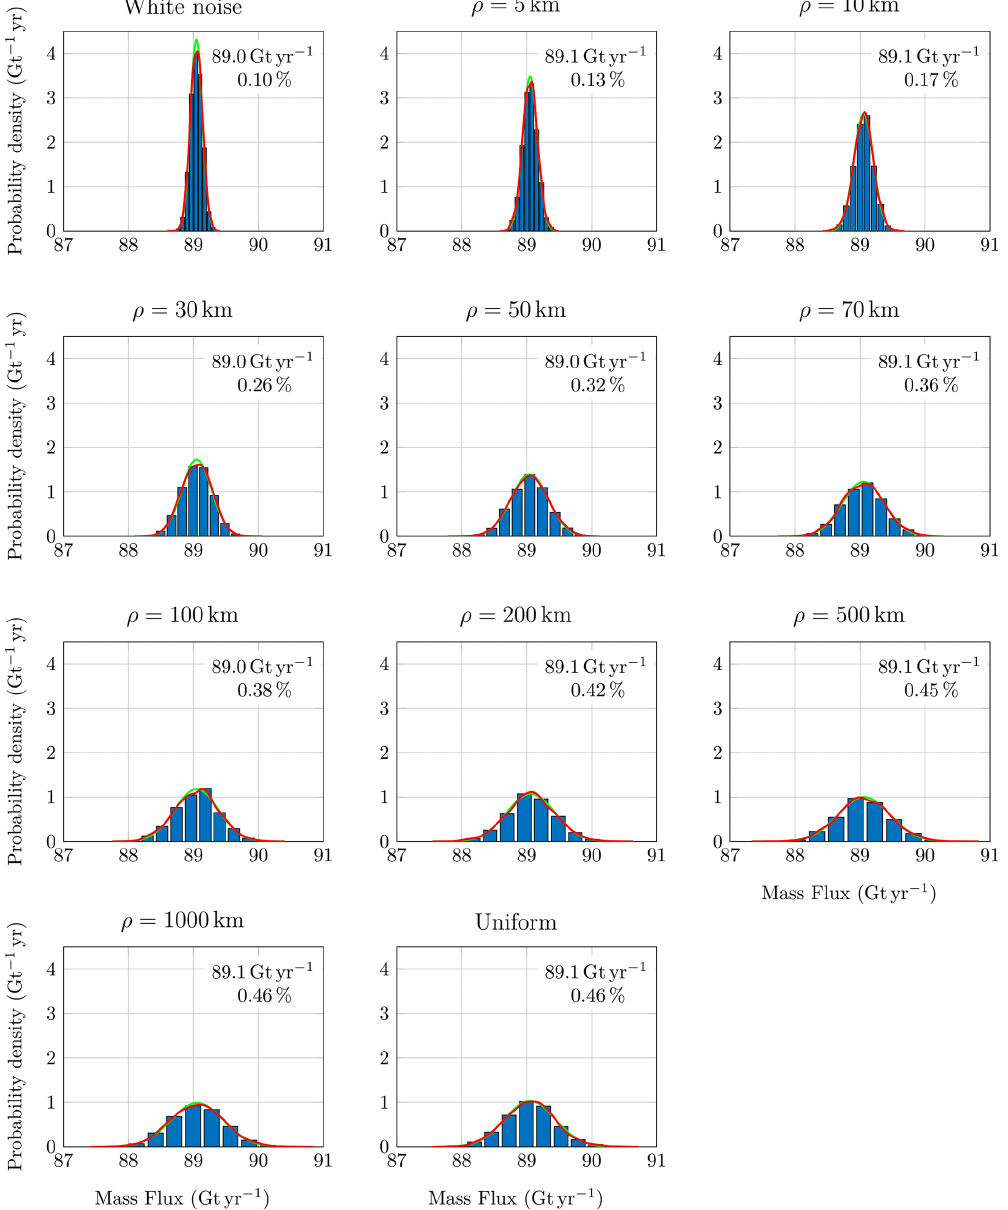
Figure 10. Normalized histograms for mass flux across fluxgate 3 (see Fig. 5) for different parameter ranges. The mean µ (in Gtyr − 1 ) and the coefficient of covariation are provided for each parameter range. The kernel density estimate of the probability density function is shown in red, and its Gaussian approximation with corresponding mean and coefficient of variation is shown in